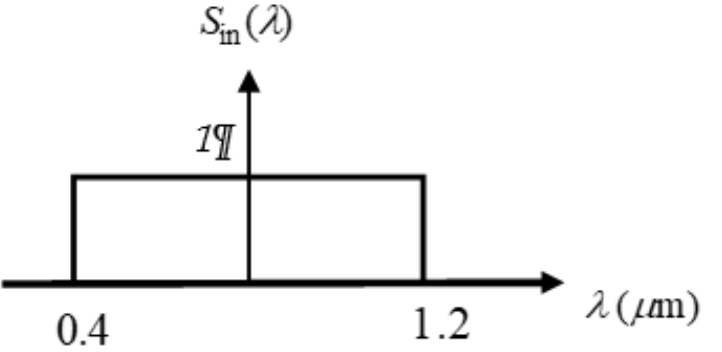
Figure 6. The incident flat-top polychromatic spectrum in ( ) S  .